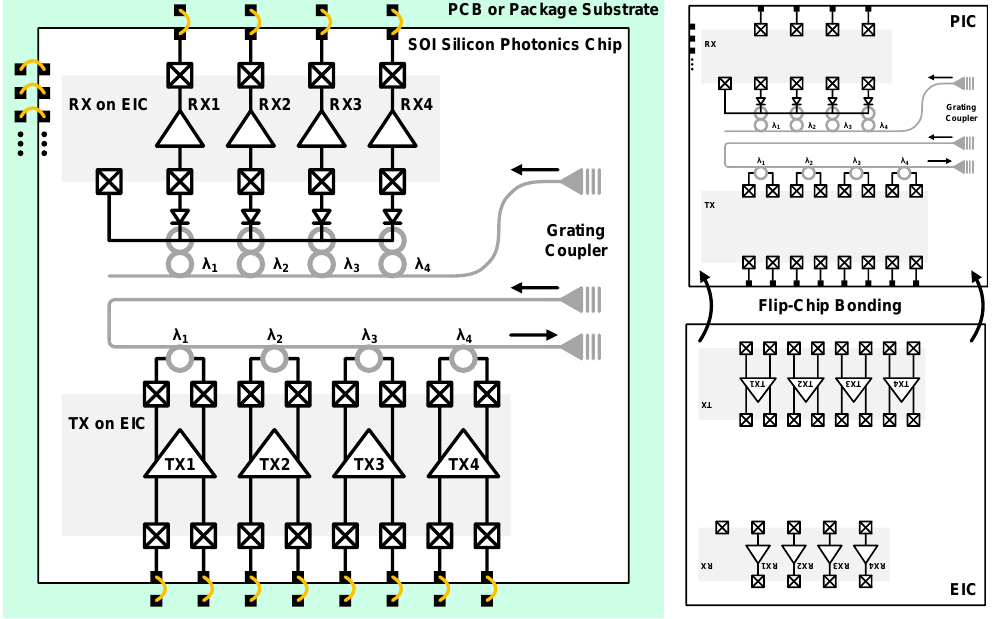
Figure 17. EIC flip-chip bonded to macro-PIC [43].